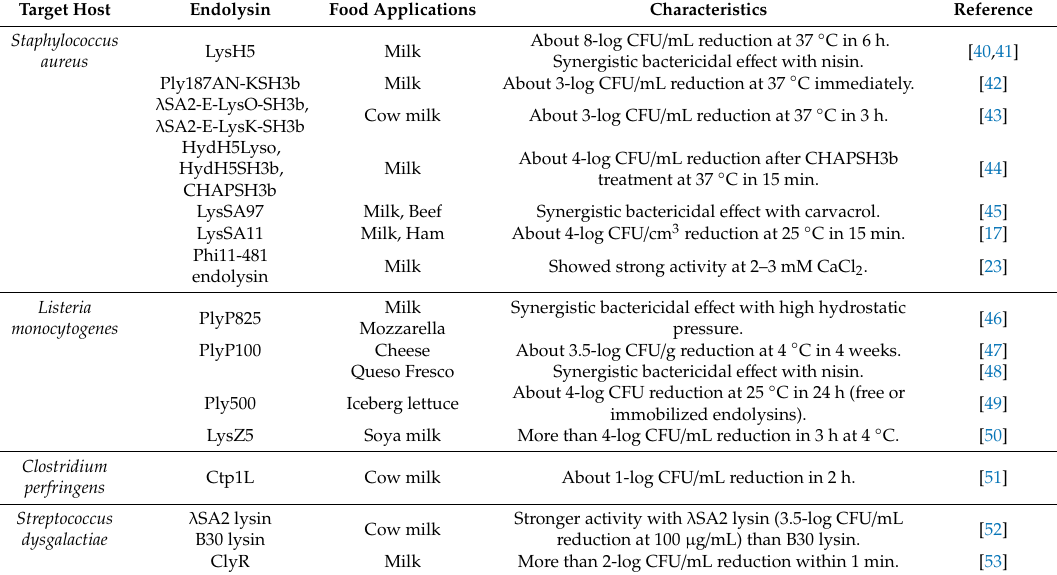
Table 1. Summary of the endolysins application against various foodborne pathogens in